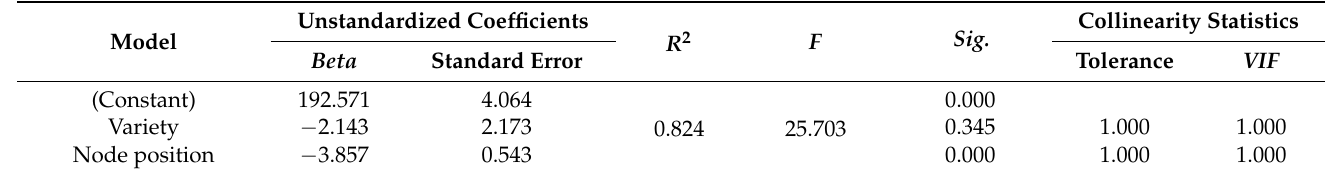
Table 7. Table of regression coefficients of the circumferential angle of banana